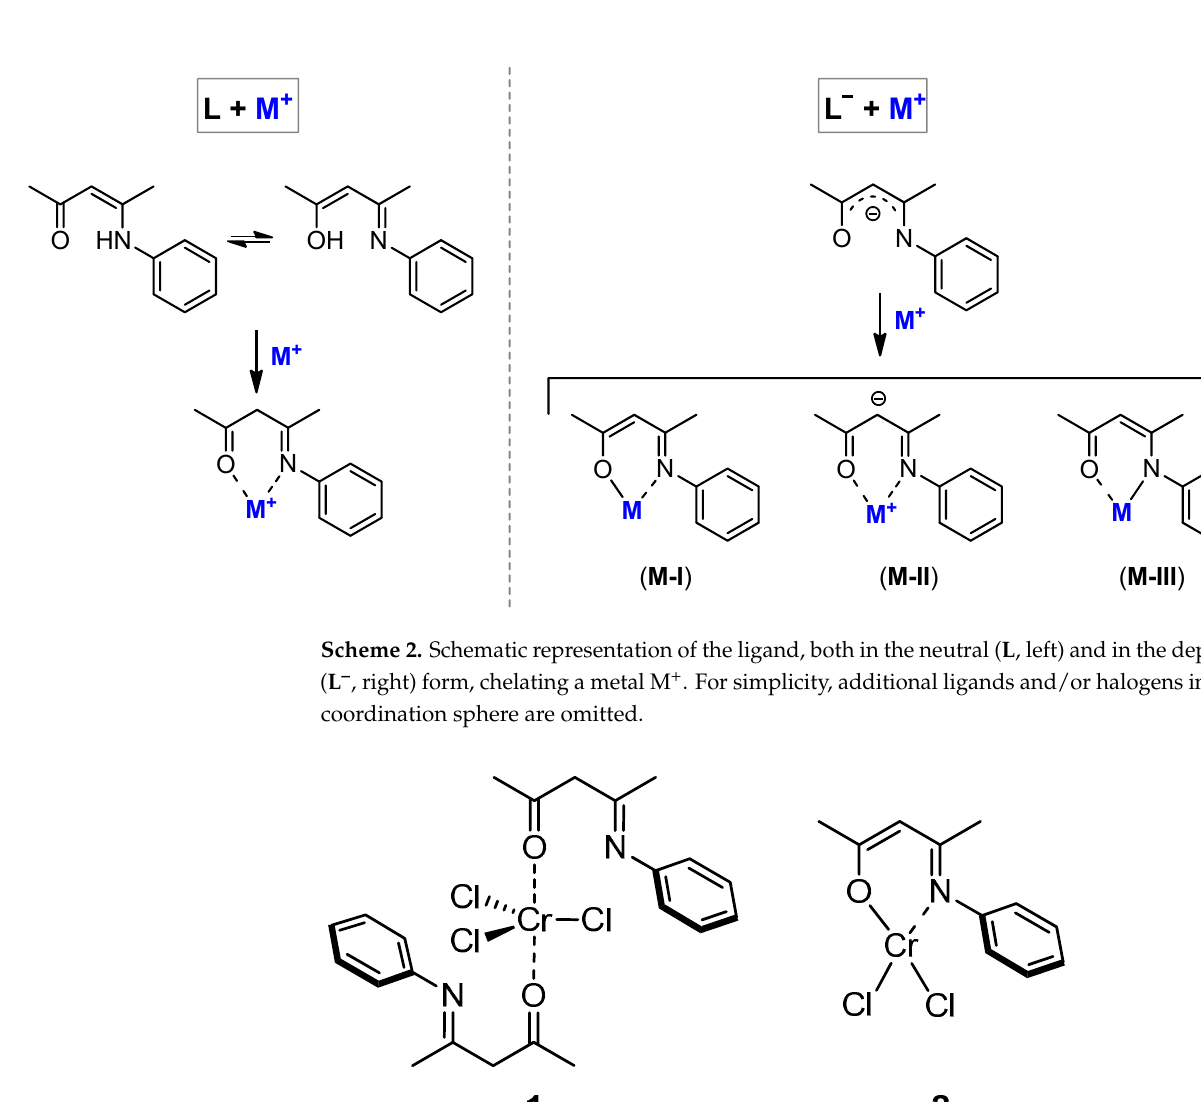
Figure 4. Schematic representation of the molecular structure of the two Cr ‐ based ketoiminato complexes, as determined by ATR ‐ IR spectroscopy coupled with elemental analysis. The C=N and C=O bonds have been localized according to the IR results. Full lines indicate covalent bonds, while dashed and dotted bonds indicate ionic interactions of decreasing strength.